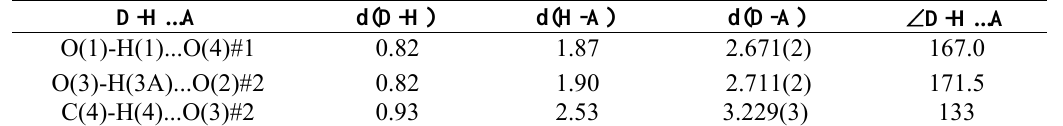
Table 4. Intermolecular hydrogen bond lengths (Å) and bond angles